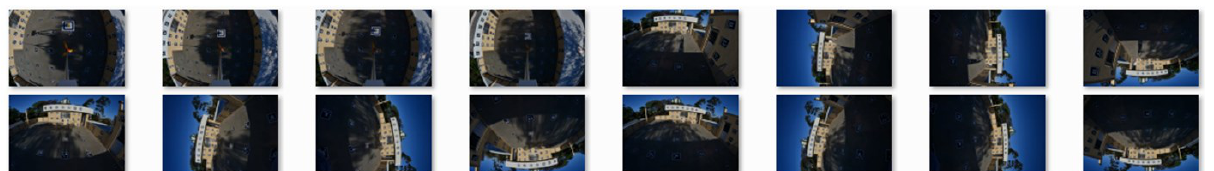
Figure 6 - Images acquired with Nikkon D 3100 camera with Samyang 8 mm fisheye lens over the 3D calibration field with coded